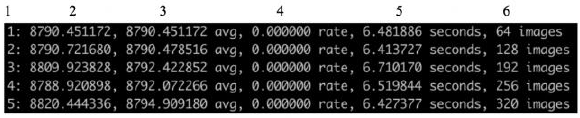
Figure 8. Training log output from YOLOv3 network with pretrained model